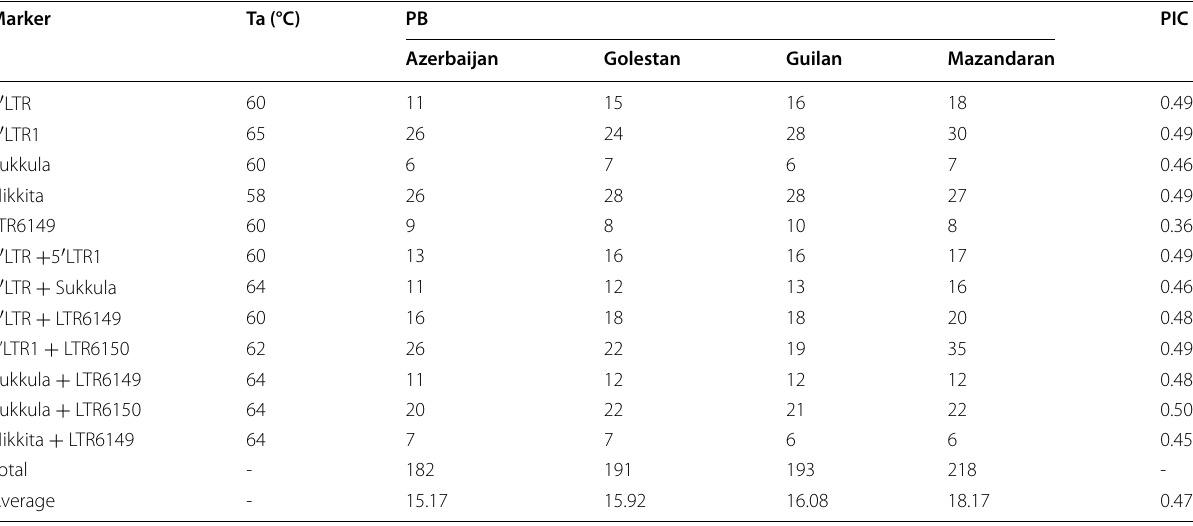
Table 2 Annealing temperature (Ta), number of polymorphic bands (PB), and polymorphic information content (PIC) for primer/ primer combinations in IRAP study Marker